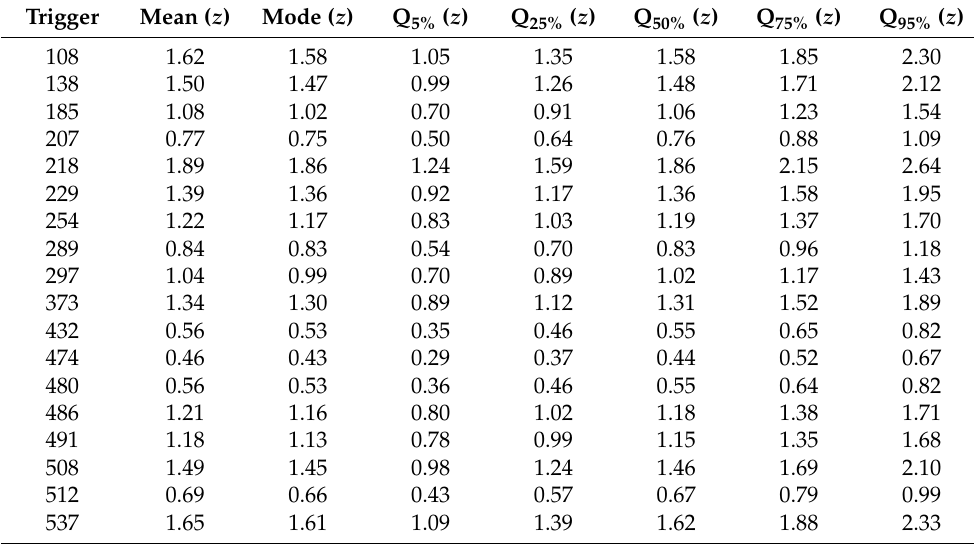
Table 2. BATSE 565 SGRB Redshift